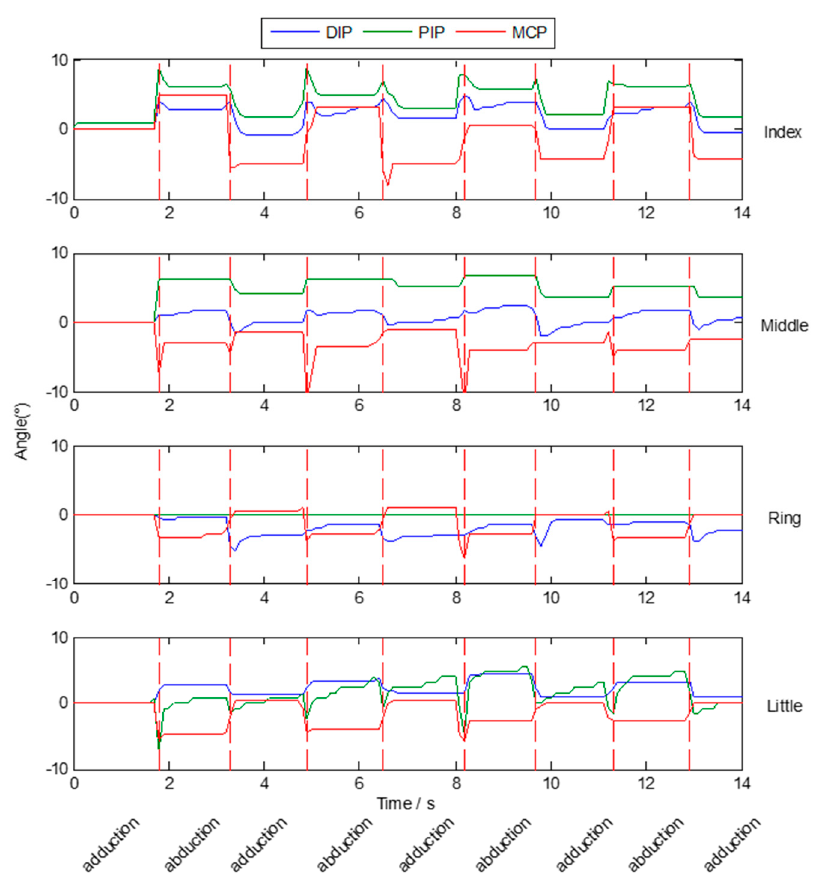
Figure 18. Finger joint angles when a subject makes a continuous abduction and adduction mo- tion.